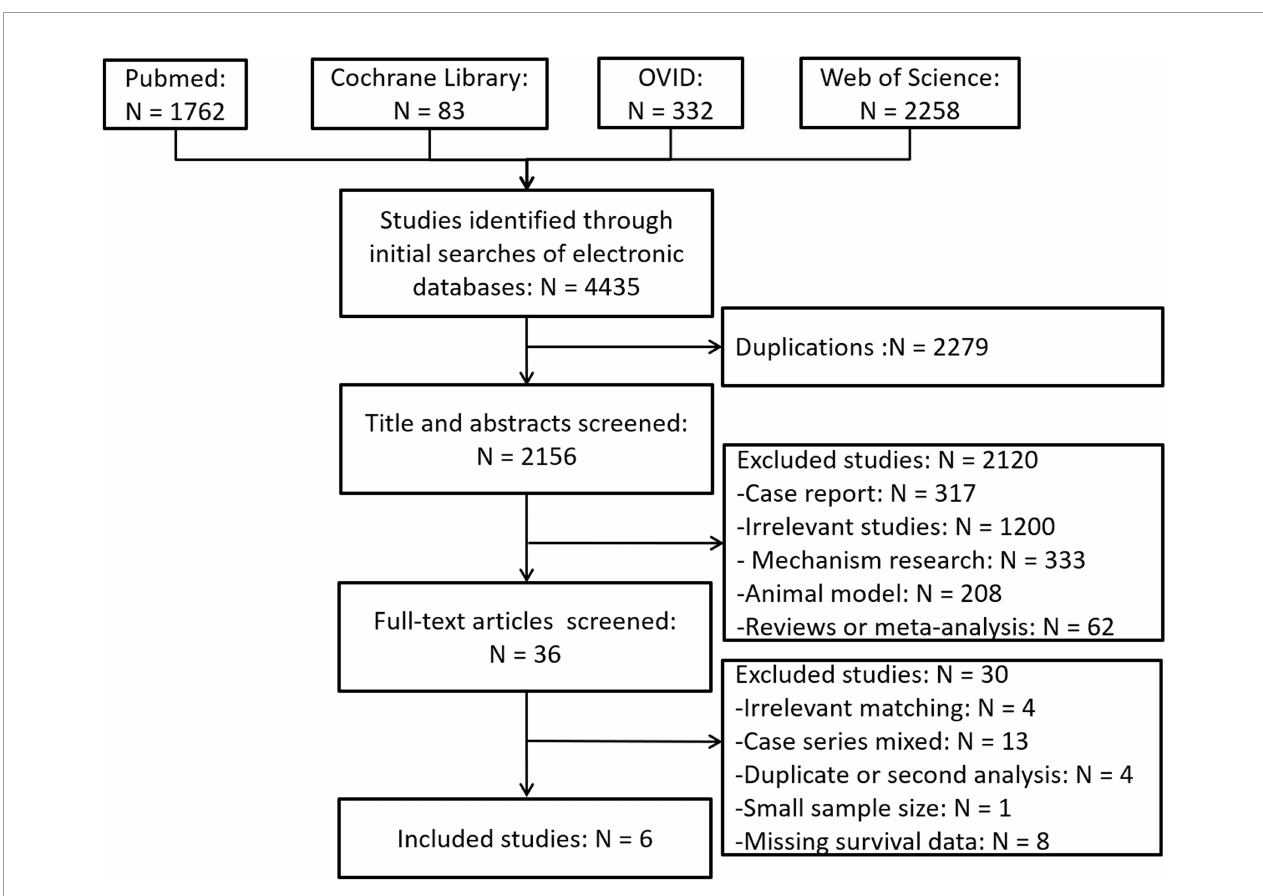
FIGURE 1 | Schematic illustration of the literature search and study-selection